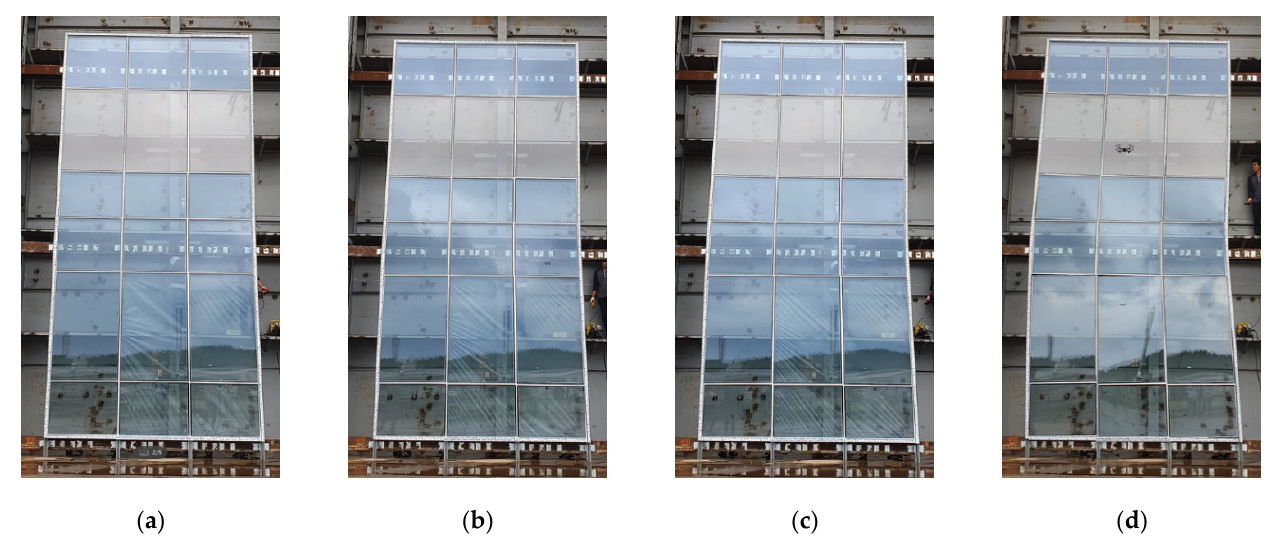
Figure 3. Applied displacement based on seismic grade: ( a ) Special level ± 36 mm; ( b ) I level ± 54 mm; ( c ) II level ± 72 mm; ( d ) AAMA 501.6 level ± 150 mm.